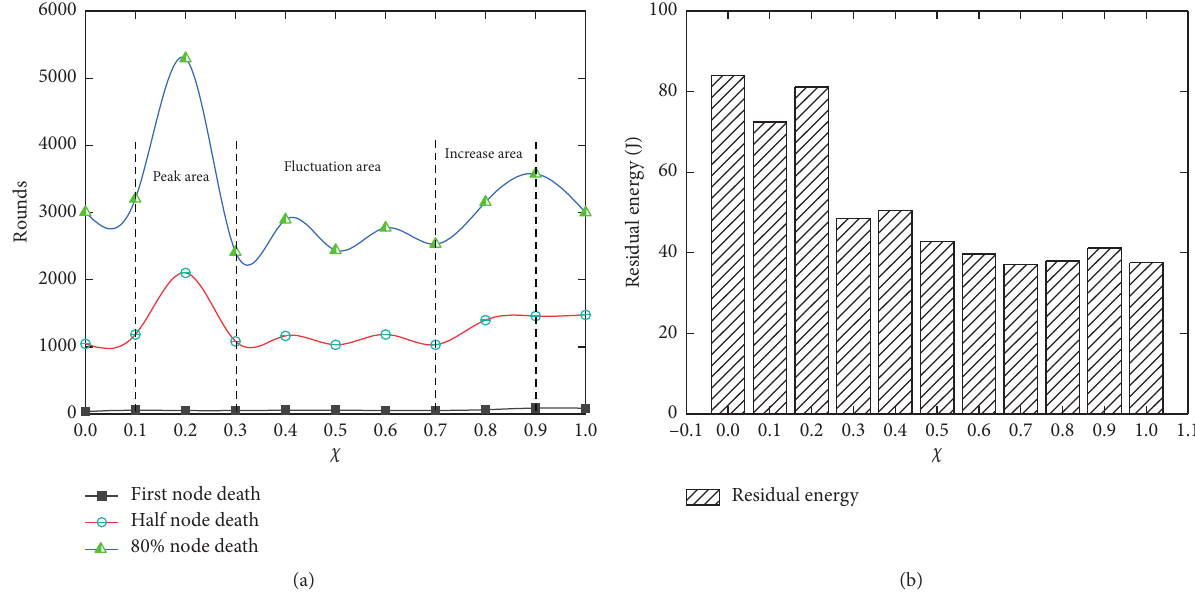
Figure 7: Assessment metrics with varying χ : (a) impact of χ on death round and (b) impact of χ on residual energy.